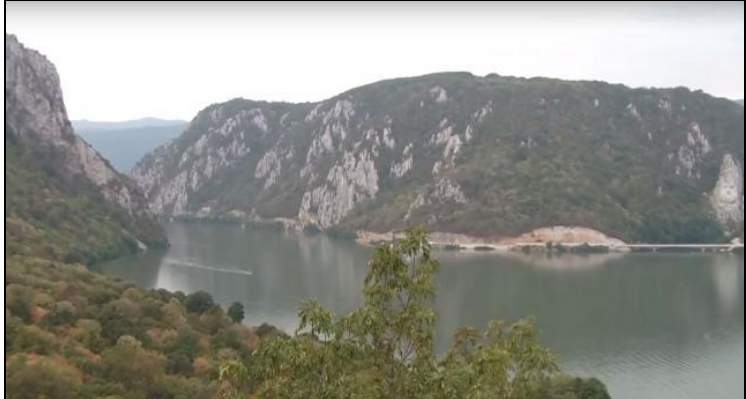
Figure 17. Đerdap Gorge on the Danube